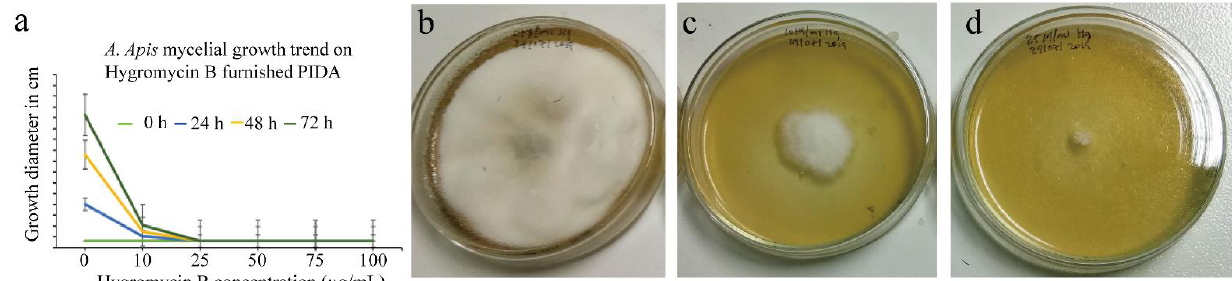
Figure 2. Ascosphaera apis ( A. apis ) mycelial growth limiting concentration level of hygromycin B. ( a ) Graphical hygromycin B resistance level test of A. apis ; ( b ) 0 µg/mL hygromycin B; ( c ) 10 µg/mL hygromycin B; ( d ) 25 µg/mL hygromycin B.